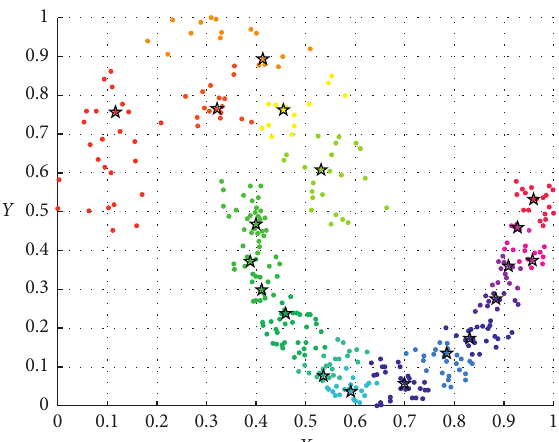
Figure 4: NNEGs of the Jain dataset. The diverse colors present different NNEGs, and the stars mark the zero samples.